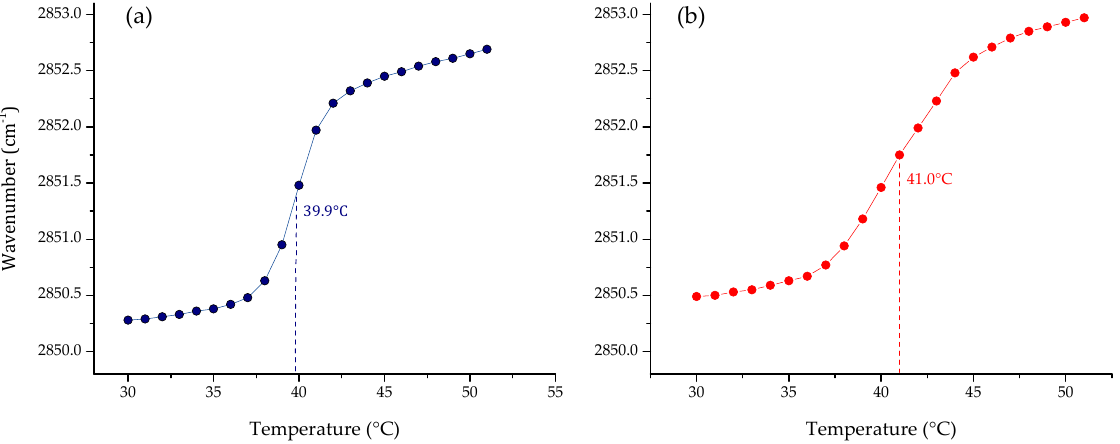
Figure 2. Peak positions of the ν s CH 2 vibration bands of the methylene groups as a function of temperature of the representative model of ( a ) non-cancer (PC:SM:PE; 4.35:4.35:1 w / w ) and ( b ) cancer cell membranes (PC:SM:PE:PS; 3.85:3.85:0.8:1.5 w / w ) in buffer (10 mM HEPES, 500 mM NaCl, 1 mM EDTA, pH 7.4).